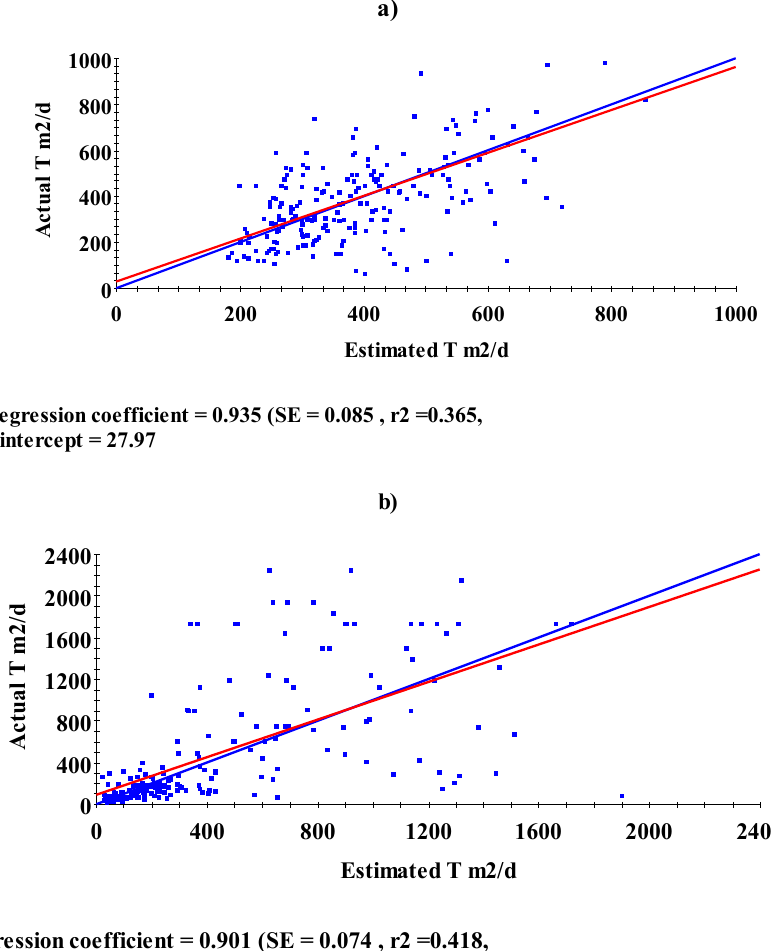
Figure 10. Scatter plot of the estimated versus the actual T values of Kg ( a ) and Dm ( b ) aquifer. The r 2 is low for both Kg (0.365) and Dm (0.418). It is worth mentioning that high r 2 is certainly